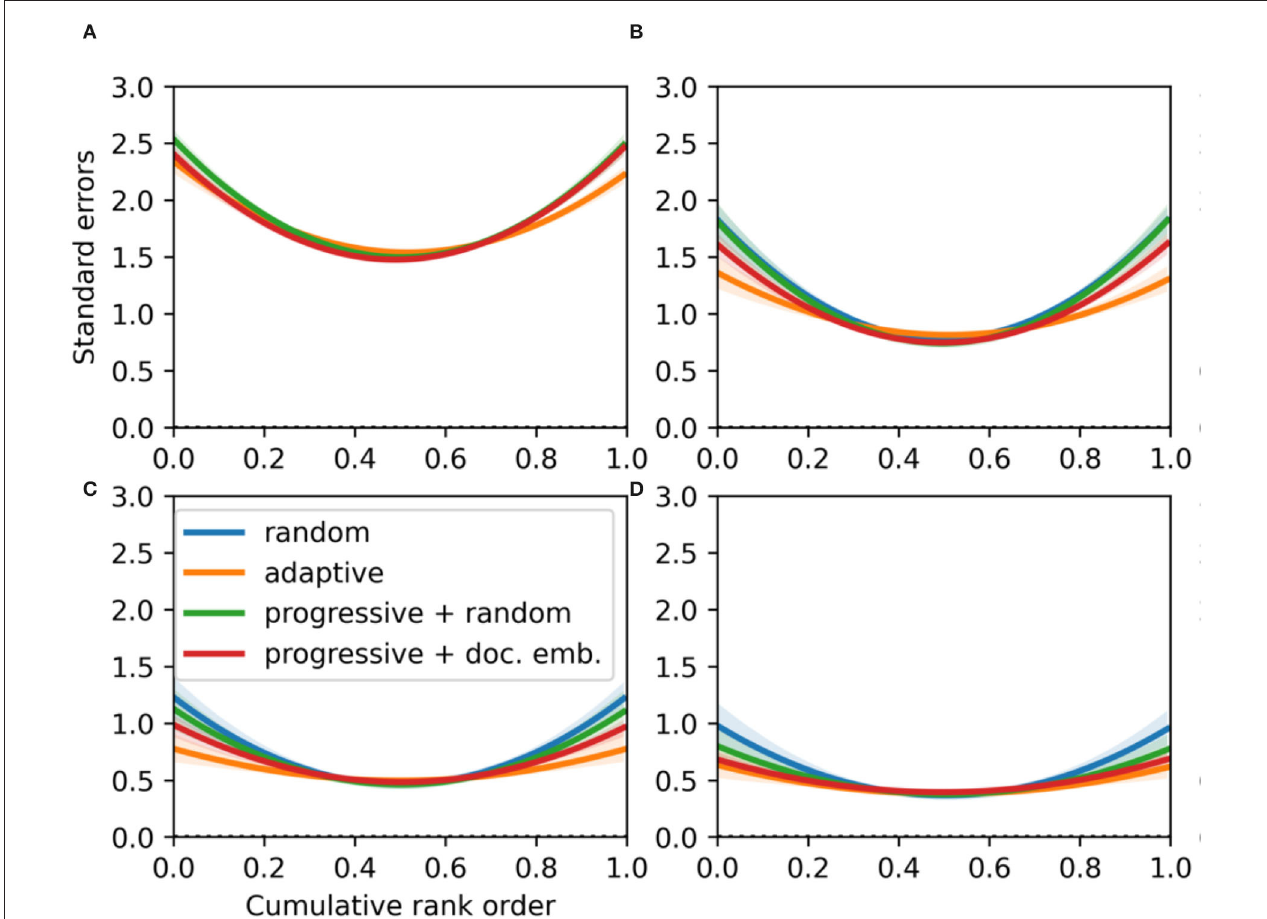
FIGURE 7 | For essay set 1 ( N 1 = 141), the precision of quality parameter estimates with respect to their cumulative ranking for different averages of work comparisons: 5 (A) , 10 (B) , 20 (C) , and 30 (D) , respectively. This is assessed for different selection rules: random (CJ), adaptive (ACJ), and a progressive selection with a random component and with a similarity component using document embeddings (100 simulations). The solid lines indicate the mean values and the transparent bands indicate the 95% point-wise